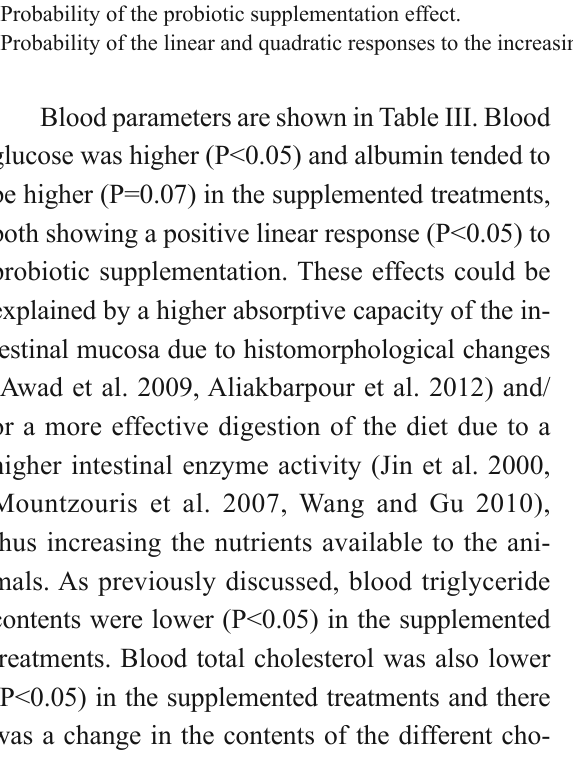
Alkaline phosphatase, U L -1 Calcium, mg dl -1 SEM: standard error of the mean.